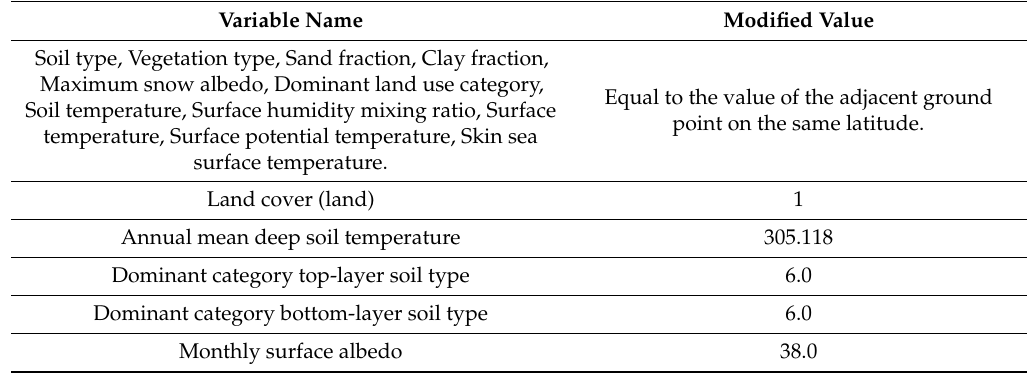
Figure 1. The WRF (Weather Research and Forecasting) model domain; ( a ) with Red Sea water and topography (m), ( b ) without Red Sea water, ( c ) without Red Sea topography, and ( d ) without Red Sea topography and water. EQ refers to Equator. Table 1. The modification in the variables related to the Red Sea surface properties.